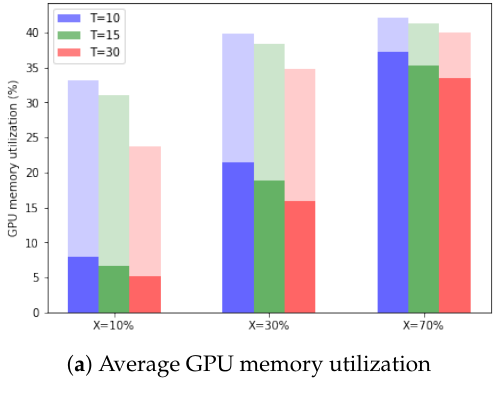
Figure 10. GPU usage and memory utilization based on T when X = 70% (in the case of θ m = 10).